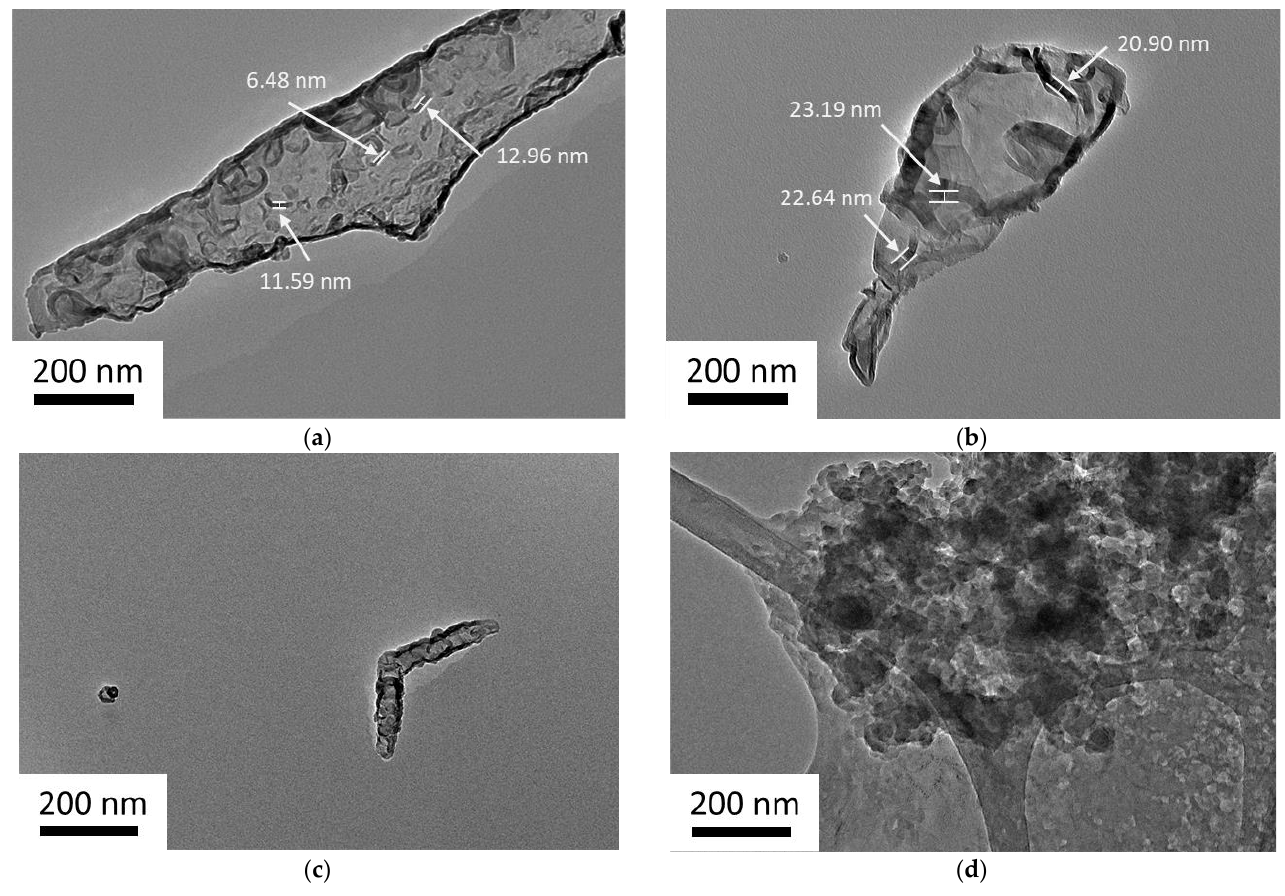
Figure 1. TEM images of purified L – CNCs in ( a ) and ( c ) and native L – CNCs in ( b , d ).